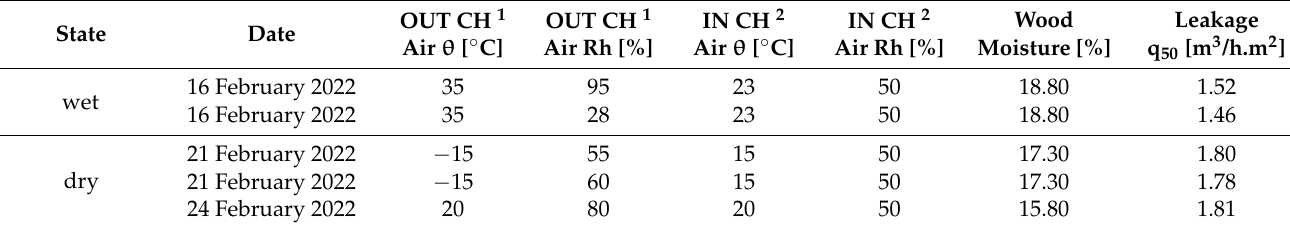
Table 2. Measurements of the air permeability in a dry and a wet